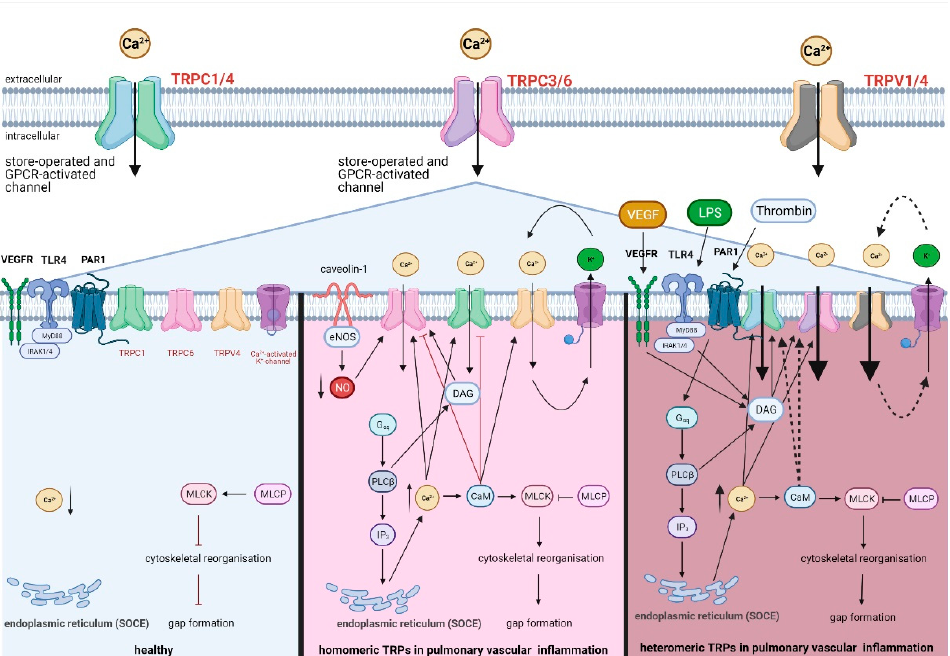
Figure 3. Regulation of endothelial permeability in acute pulmonary inflammation by homomeric and heteromeric TRP assemblies. Under physiological conditions (left), pro-inflammatory and barrier-disruptive receptors including TLR4 (Toll-like receptors), PAR1 (protease-activated recep- tor 1) and VEGFR (vascular endothelial growth factor receptor) are not activated by their respective ligands, and intracellular Ca 2+ concentration is maintained low by closed confirmations of TRP homomers. In vascular inflammation with TRP homomers (centre), TRPC6 is activated by DAG (diacylglycerol) and by inhibition of NO production through eNOS (endothelial NO-synthase) un- coupling and eNOS interaction with caveolin-1. In parallel, TRPC1 is activated by IP 3 (inositol 1,4,5-trisphosphate)-dependent Ca 2+ release. TRPC6-mediated Ca 2+ influx can then be inhibited in a Ca 2+ /CaM (calmodulin)-dependent manner as part of a negative feedback regulation which could (potentially) also be the case for TRPC1. TRPV4-mediated Ca 2+ influx increases K + efflux via inter- mediate and small Ca 2+ -activated K + channels (IK and SK), causing endothelial hyperpolarization which in turn increases Ca 2+ influx. In vascular inflammation with TRP heteromers (right), activation of PAR1, TLR4 and VEGFR by their respective ligands thrombin, lipopoly-saccharide (LPS) or VEGF, respectively, causes GPCR-operated activation of TRPC1/4 and TRPC3/6, and the resulting Ca 2+ influx is stabilized by SOCE. The Ca 2+ influx may be further stabilized via K + efflux maintaining TRPV1/4 activation (dashed lines) and via Ca 2+ /CaM-complexes binding to their CaM binding sites in TRPC1/4 and TRPC3/6 (dashed lines). Heteromeric and homomeric TRP channel-mediated Ca 2+ influx activates the CaM/MLCK (myosin light chain kinase)-signaling pathway by binding to CaM which in turn activates MLCK. Activated MLCK inhibits MLCP, thereby activating MLC II (myosin light chain II), actin-myosin interaction and formation of F-actin stress fibers. The resulting tensile force on endothelial cell–cell-junctions (inside-out-signaling) causes inter-endothelial gap formation and endothelial barrier failure. Created with